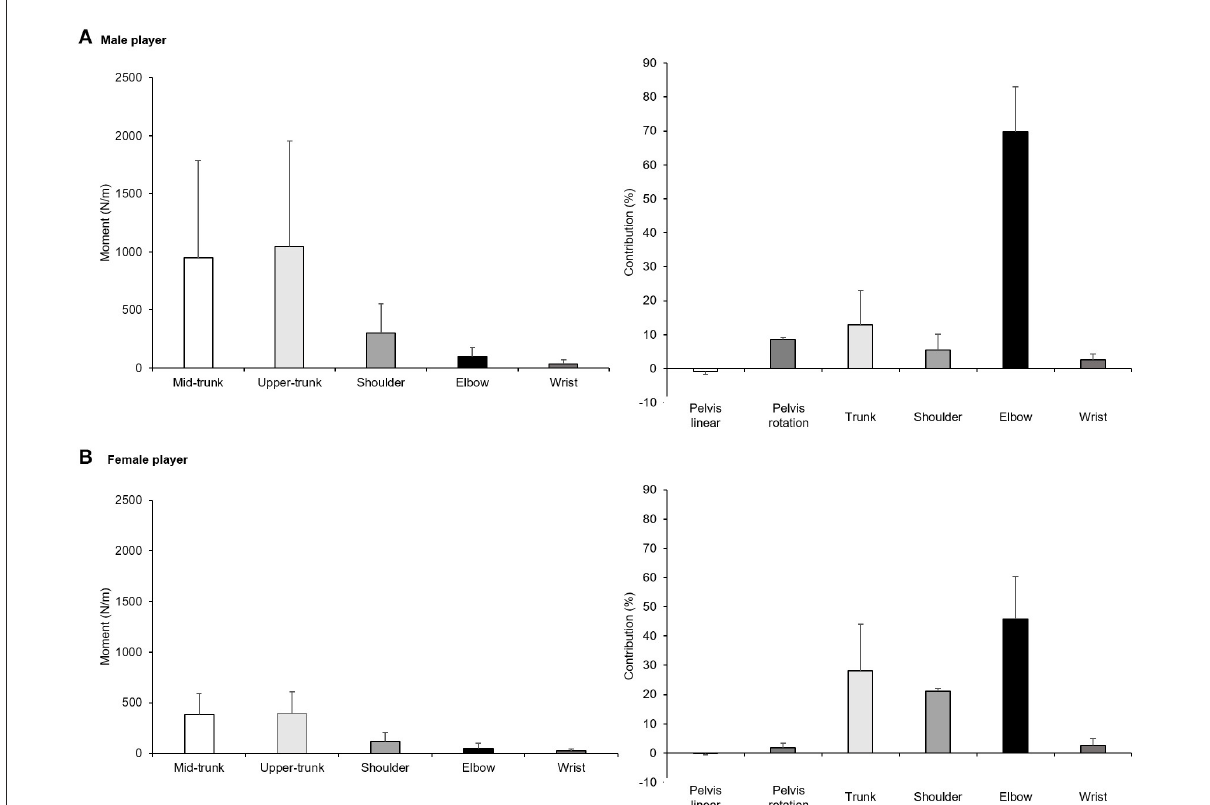
FIGURE2 Segmental contributions during loading, ball contact and finish stages of the serve for the male [upper panel, (A) ] and female tennis player [lower panel, (B) ]. Values are means ± SD from trials 1 and 2.